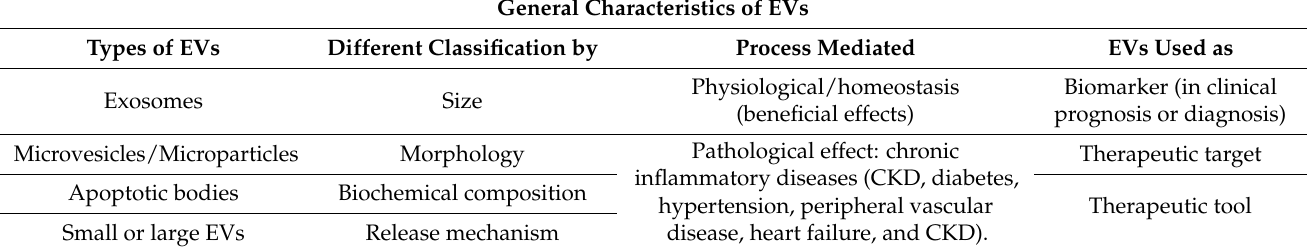
Table 1. Principal features of